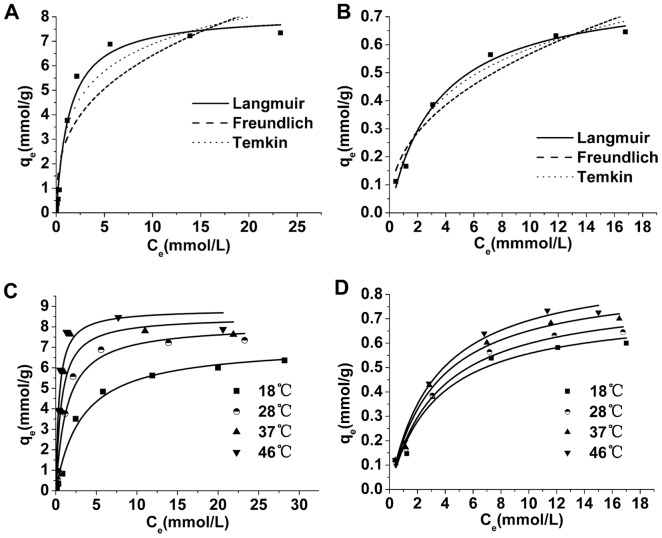
The fitting lines of isothermal models of Ag+ adsorption.The fitting lines of different isothermal models at 28°C for BMO (A) and CMO (B), and the Langmuir model at different temperatures for BMO (C) and CMO (D).